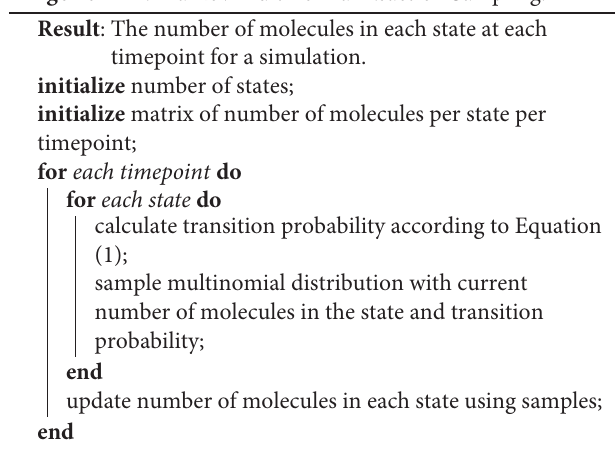
transition probabilities P ij describe a partition of unity ( Figure 4 ).